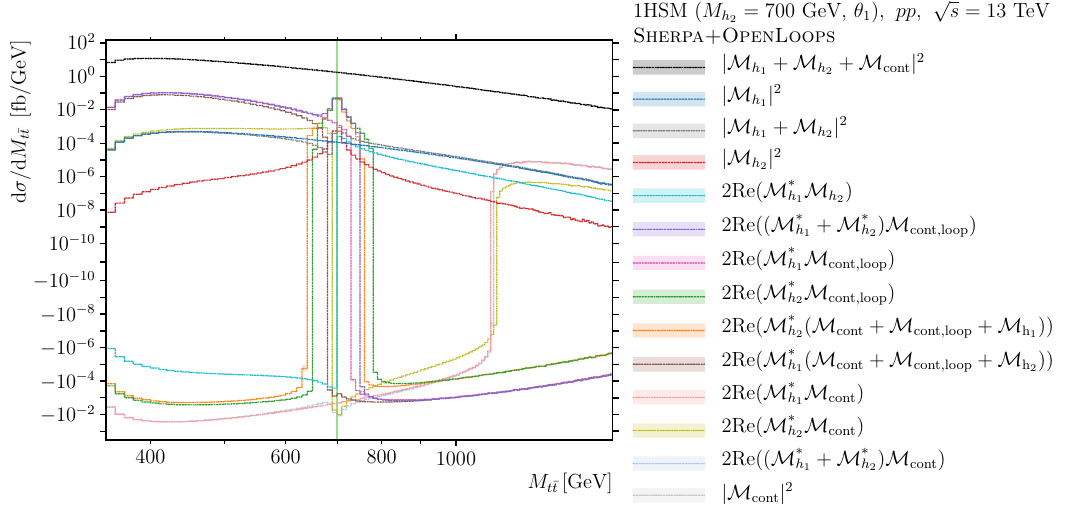
h 1 , h 2 ) t ¯ t b ¯ b (cid:25) ¯ ν ¯ (cid:25) (cid:31) ν (cid:31) in the 1HSM → { } → →